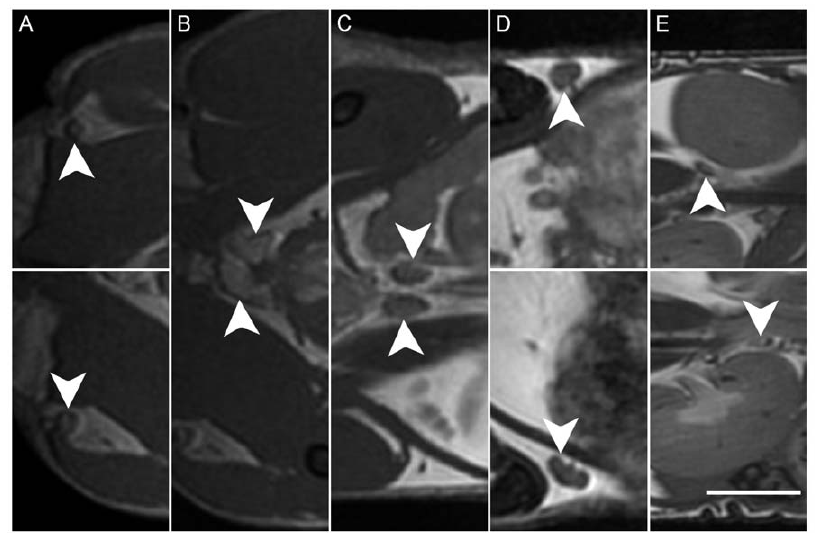
Figure 5. Sections of coronal view of mouse with prostate and lymph nodes identified. Tail is at left, head at right. White arrows indicate organs of interest as follows. A: popliteal lymph nodes; B: prostate; C: iliac lymph nodes; D: inguinal lymph nodes with lymph vessels visible; E: Renal lymph nodes. Scale bar is 0.5 cm. Coronal scan, FOV 6 6 3.3 cm, 200 m m isotropic resolution, TR/TE=4.6/2.3 ms, BW 6 62.5 kHz, FA 40 u , 8 PC, 2 NEX, 26 minutes.